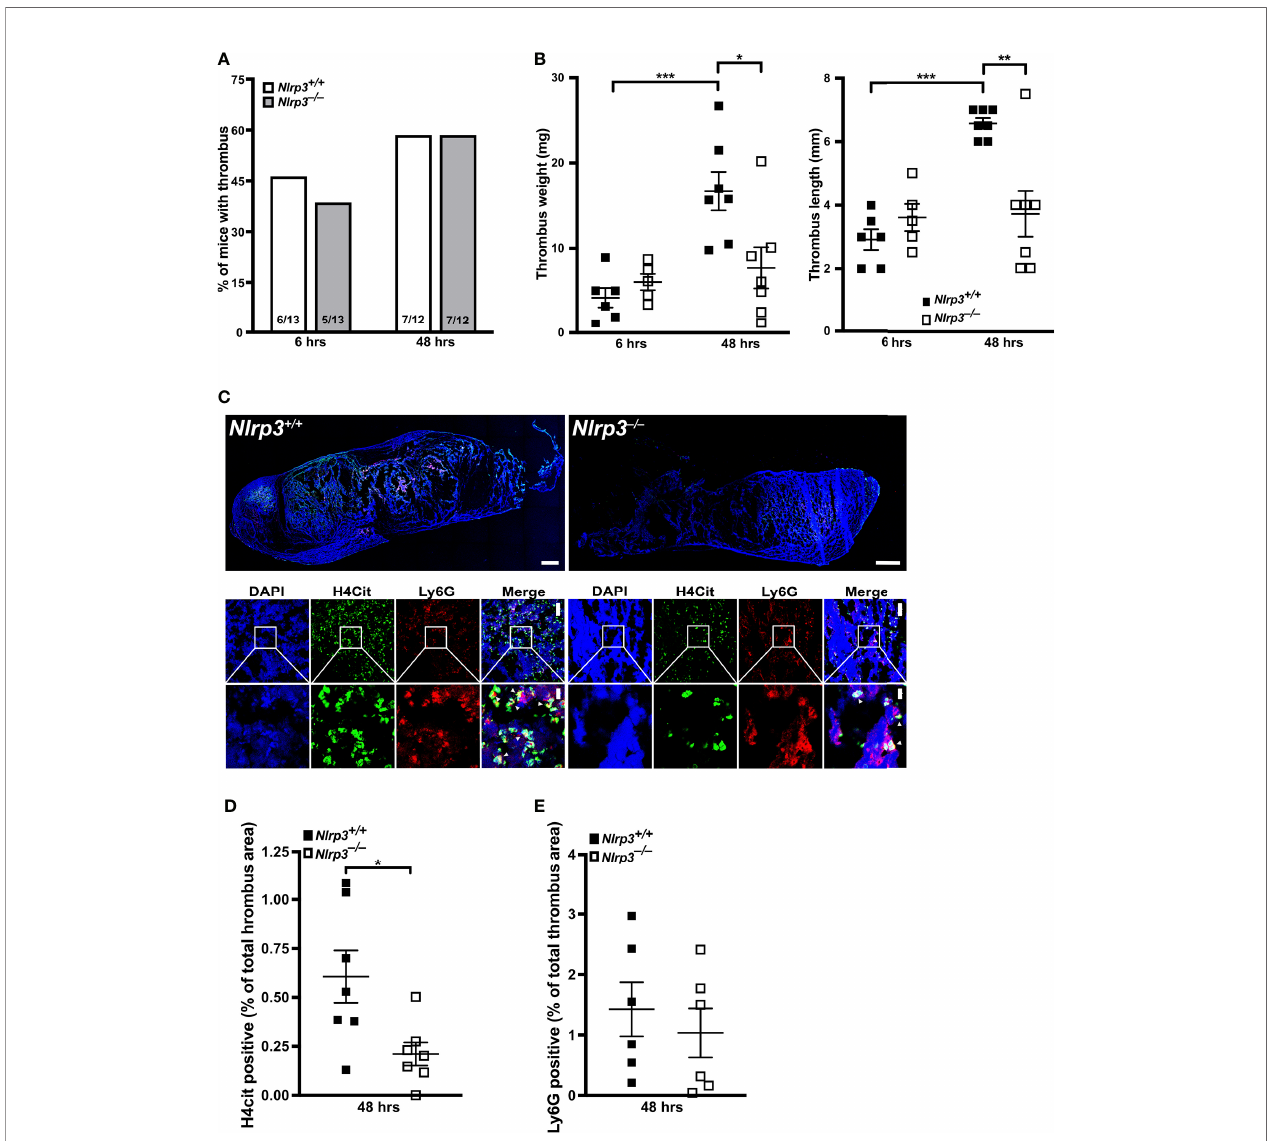
FIGURE 5 | NLRP3 de fi ciency decreases NETosis and thrombus growth in a stenosis-induced model of deep vein thrombosis. (A) Thrombus incidence in wild-type ( Nlrp3 +/+ , open bars) or Nlrp3 – / – mice (grey bars) after 6 or 48 hours of stenosis of the inferior vena cava (IVC). (B) Thrombus weight (left panel) and thrombus length (right panel) of thrombi from wild-type ( Nlrp3 +/+ , black) or Nlrp3 – / – mice (white) after 6 or 48 hours of stenosis of the IVC. Each dot represents a thrombus. * p<0.05, ** p<0.01 and *** p<0.001. (C) Representative composite images of thrombi by confocal microscopy (upper panels) and zoom images (lower panels) of thrombi from wild-type ( Nlrp3 +/+ ) or Nlrp3 – / – mice after 48 hours of stenosis of the IVC. Blue, DNA (DAPI); green, H4Cit antibody stain; red, Ly6G antibody staining. Overview images were composed of several photographs. Scale bar equals 300 µm (thrombus overview), 50 µm (upper panel) or 10 µm (lower panel) in the zoom panels. (D) Percentage of thrombus area covered by H4Cit in thrombi from wild-type ( Nlrp3 +/+ , black) or Nlrp3 – / – mice (white) after 48 hours of stenosis of the IVC. Each dot represents a thrombus. * p<0.05. (E) Percentage of thrombus area covered by Ly6G positive cells in thrombi from wild-type ( Nlrp3 +/+ , black) or Nlrp3 – / – mice (white) after 48 hours of stenosis of the IVC. Each dot represents a